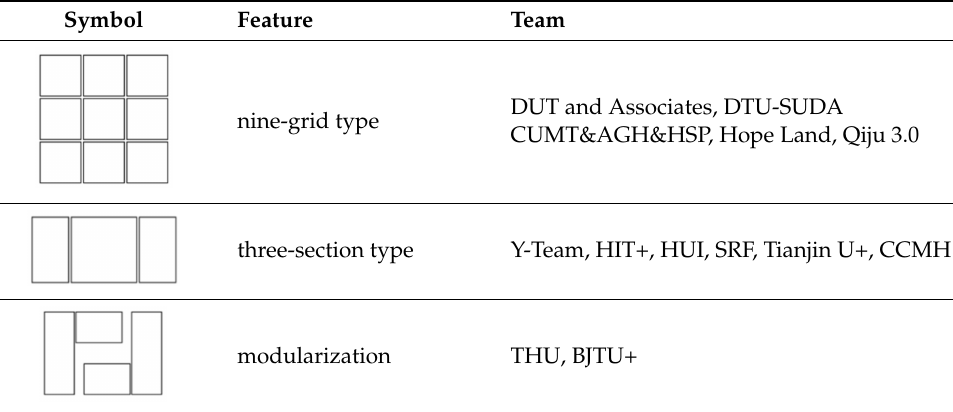
Table 4. Functional